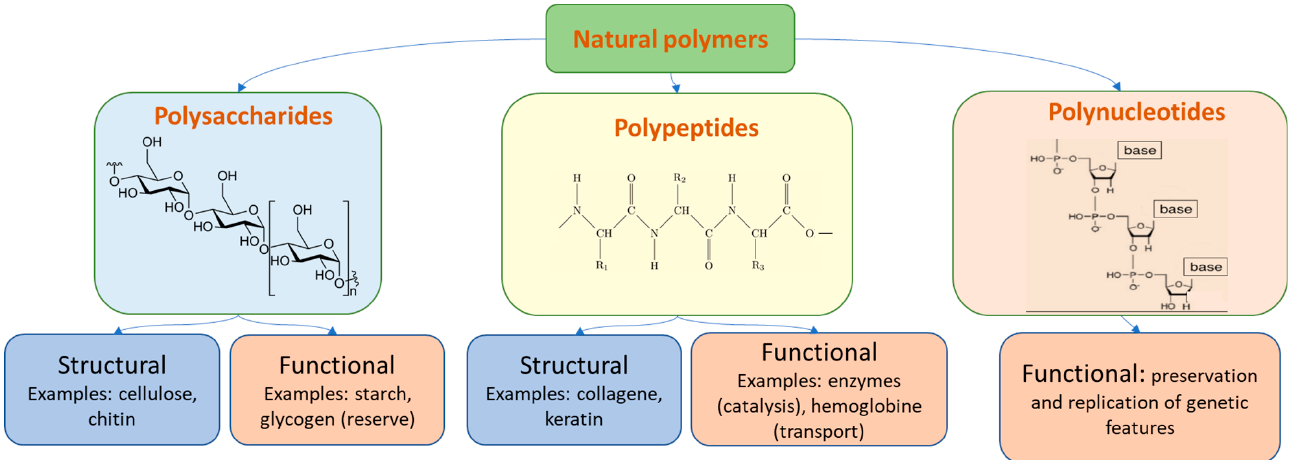
Figure 2. Scheme about the chemical structure of natural polymers and their main generical func-